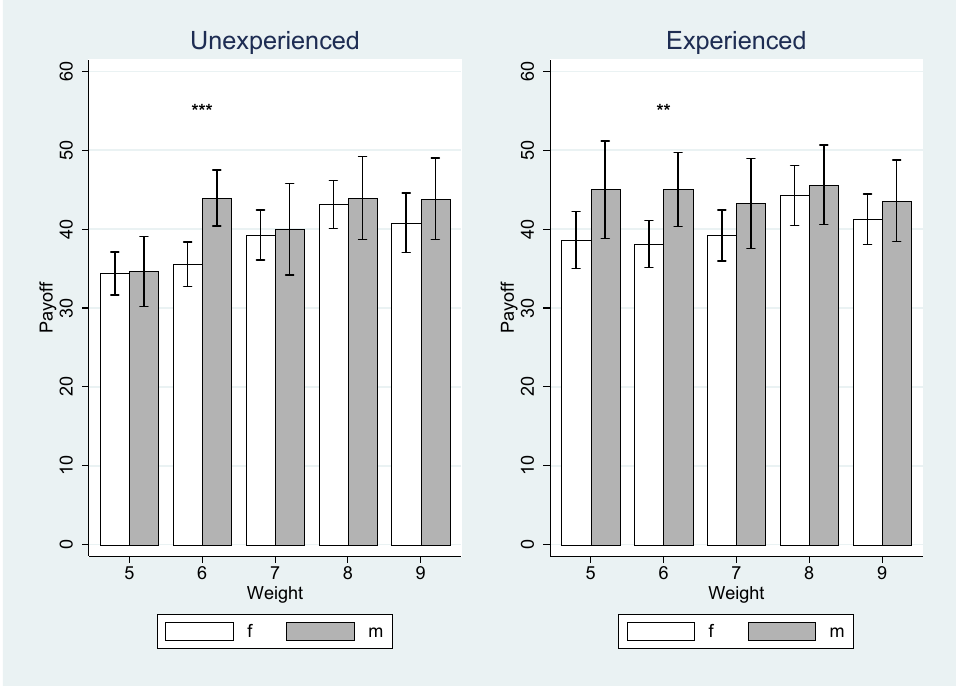
Figure A1. Proposer’s Payoff in P IT by Experience, Weight, and Gender. Average payoffs in tokens. Significance levels: * p ≤ 0.10, ** p ≤ 0.05, *** p ≤ 0.01. Error bars represent 90% confidence intervals.